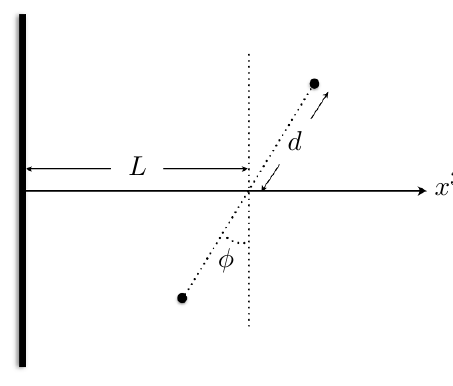
Figure 1 . Relative alignment of the two antiparallel lines (running along the x 0 direction perpen- dicular to the plane) with respect to the defect located at x 3 =